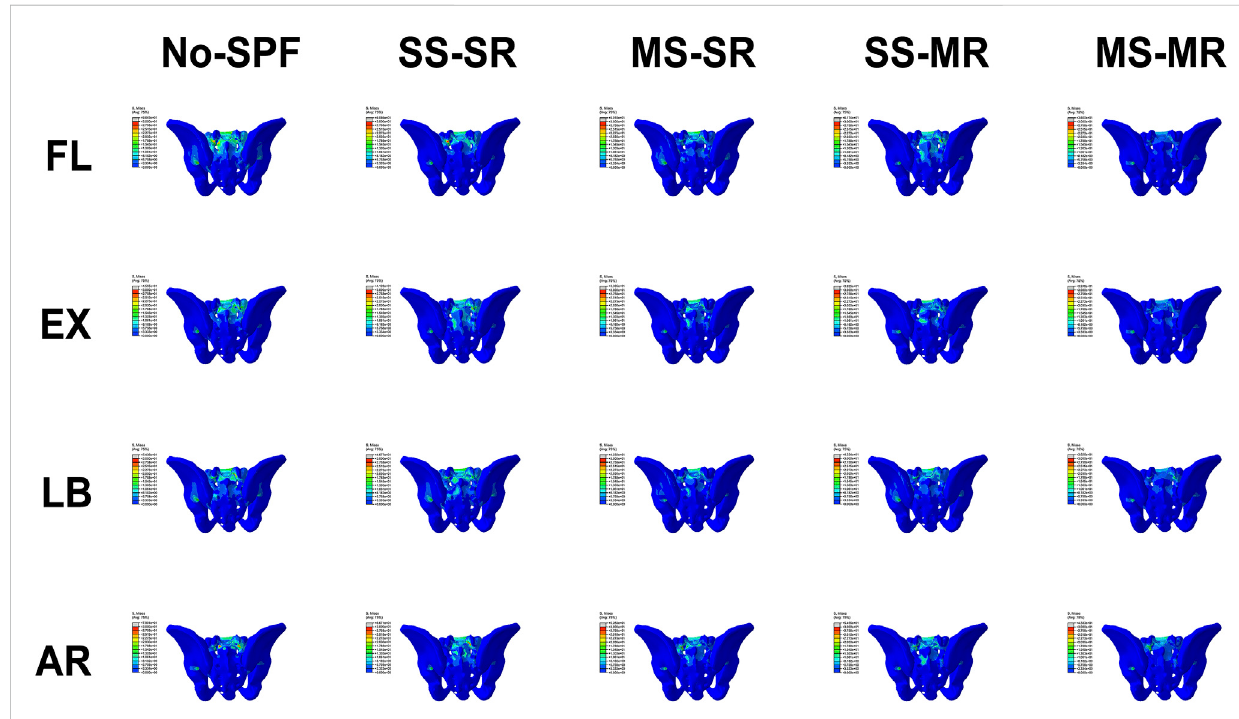
FIGURE 9 Von-Mises stress on sacrum of different instrumented models in fl exion, extension, lateral bending, and axial